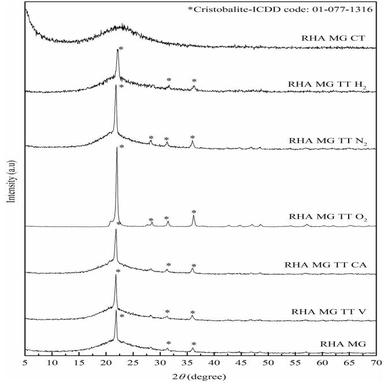
Diffractograms of raw RHA FB and the different treatments performed.